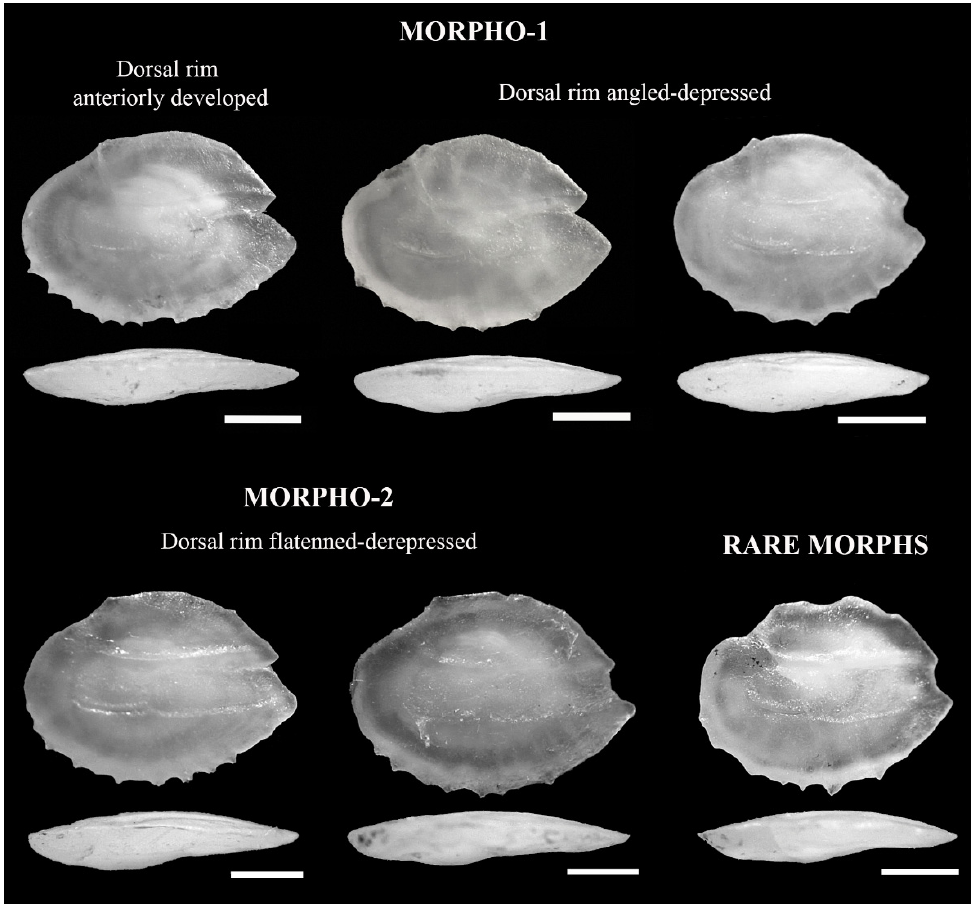
Figure 2. Image composition of otolith morphotypes according to the variability of shapes obtained from mesopelagic fish along the southeast coast of Gran Canaria island.